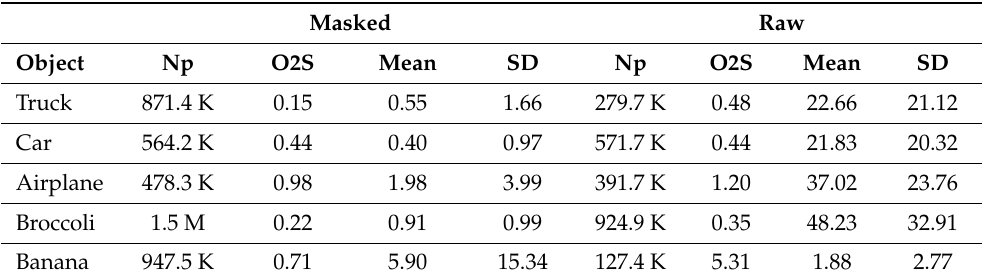
Table 7. RealityCapture masked and raw point clouds mean and standard deviation distances relative to reference point cloud in millimeters. Masked Raw